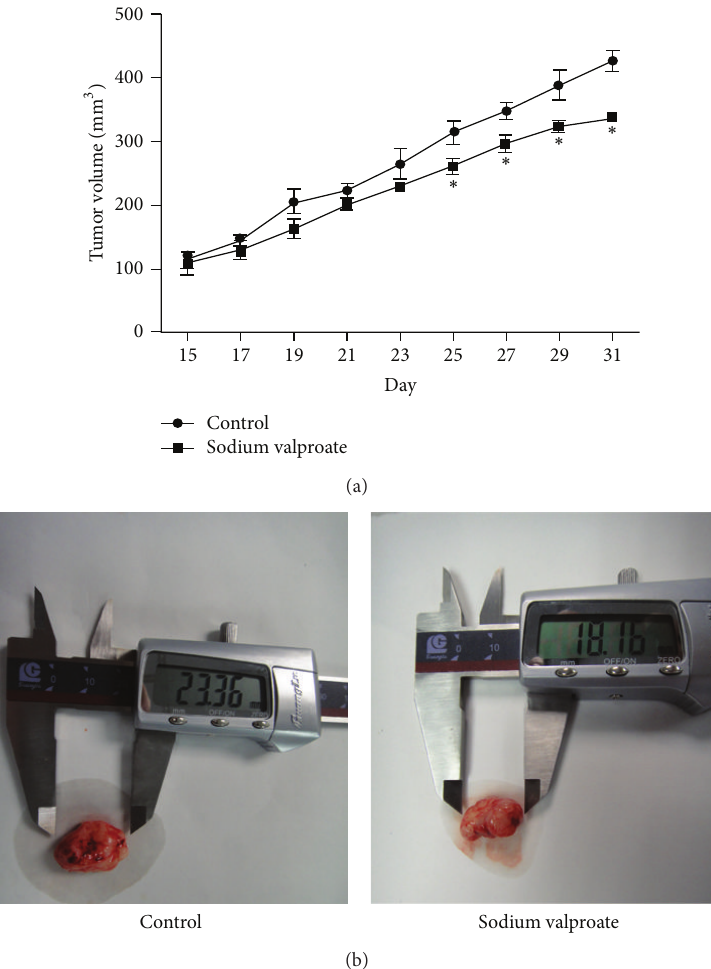
Figure 8: The effect of sodium valproate treatment on cholangiocarcinoma xenografts. (a) Tumor xenografts were established in mice by implanting TFK-1 cells on the upper-right flank. Animals were randomly divided into 2 groups and injected through i.p. with vehicle (control group) or sodium valproate (300mg/kg, every day) for 2 weeks. Values were presented as mean ± SD. ∗ 𝑃 < 0.05 compared with the control. (b) Representative tumor tissue excised from control (left) and treated groups